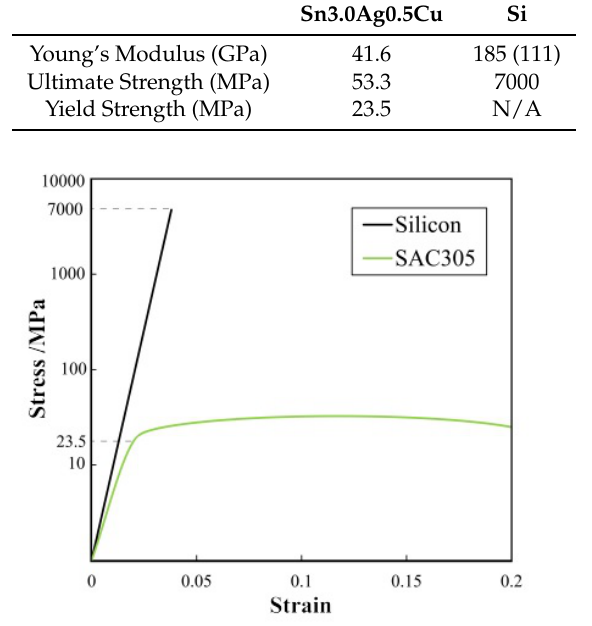
Figure 18. Stress-strain curves for silicon and SAC305